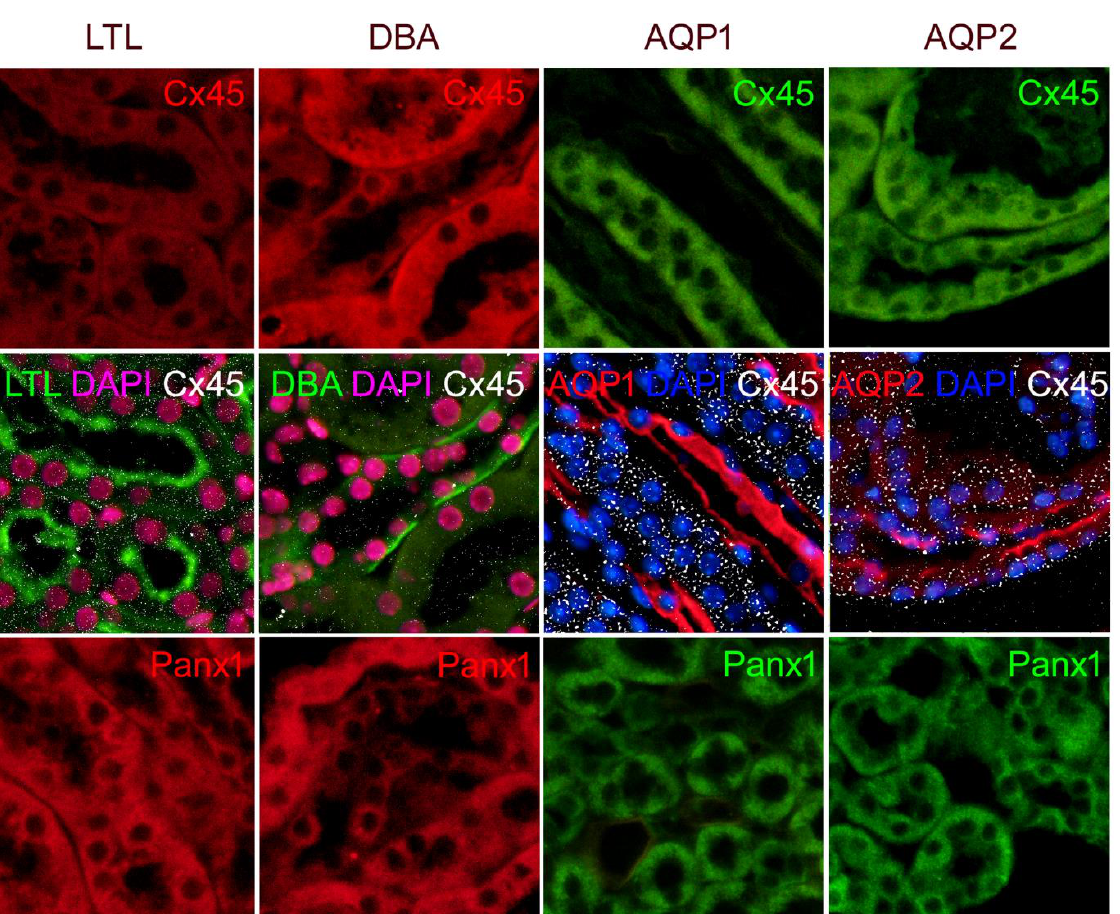
Figure 6. Colocalization of connexin 45 and Panx1 with different tubular segment markers in the mice kidney. Sections from the wild-type mice. Lotus tetragonolobus lectin (LTL), proximal tubule marker (green; first column); Dolichos biflorus agglutinin (DBA), distal tubule marker (green; second column); aquaporin 1 (AQP1), thin descending loop of Henle marker (red; third column); aquaporin 2 (AQP2), collecting duct marker (red; fourth column). Nuclei were stained with DAPI (blue in third and fourth column; magenta — pseudocolorized in first and second column); tsm — tubular segment marker. Scale-bar = 20 µm, refers to all (magnification 400×).